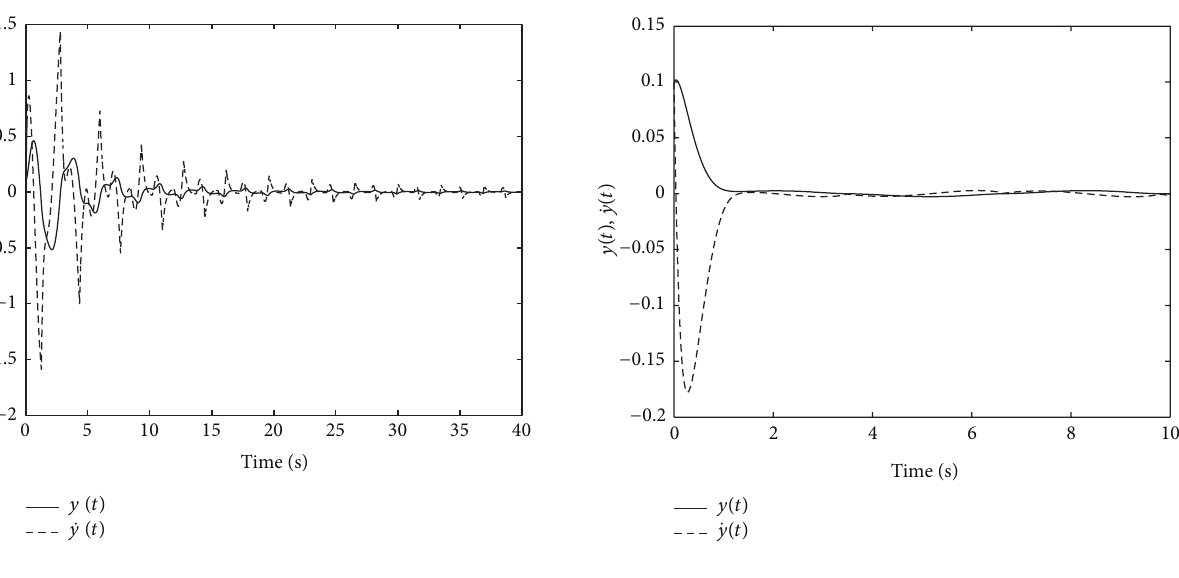
Figure 5: Time response [𝑦, ̇𝑦] 𝑇 of system (1) with the control scheme (13)–(15).